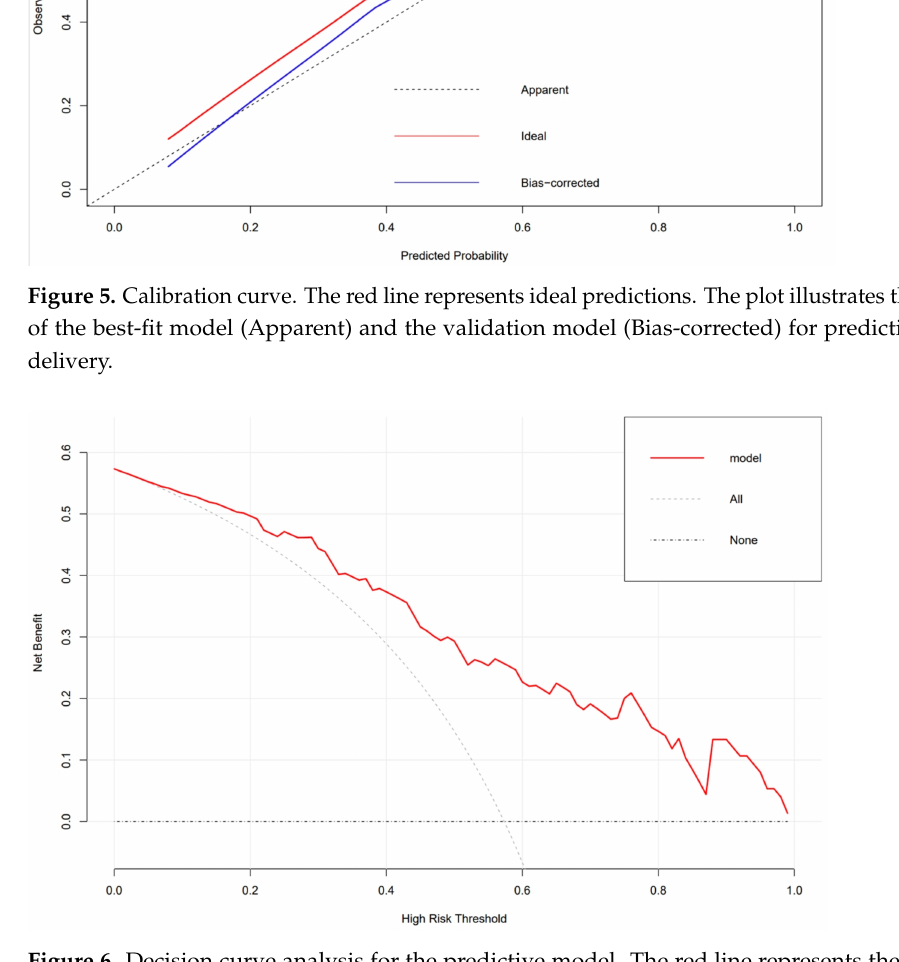
Figure 6. Decision curve analysis for the predictive model. The red line represents the prediction model. The gray dashed line assumes all women delivered vaginally and the horizontal line assumes no woman delivered